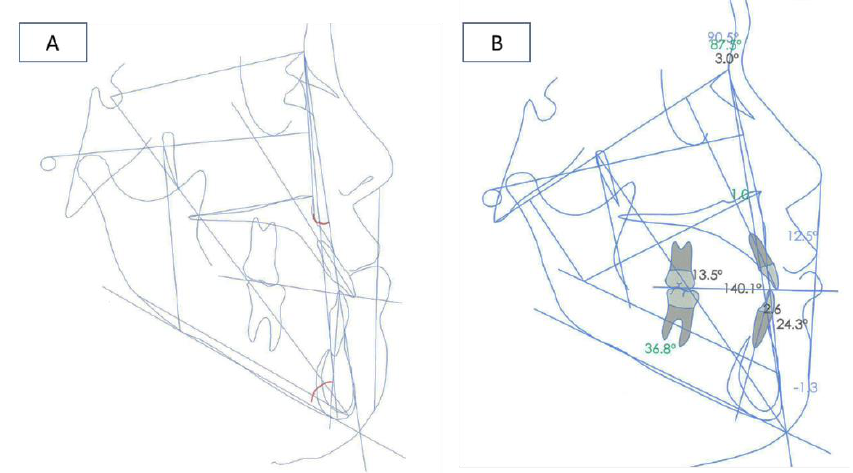
Figure 4. Cephalogram. ( A ) Pre-surgery and ( B ) post-surgery.